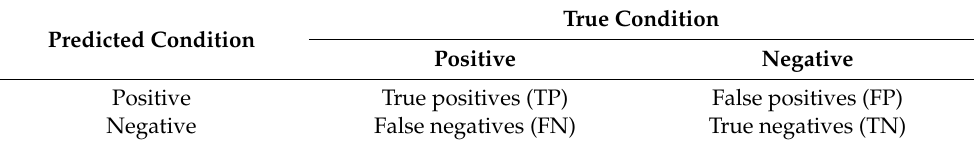
Table 2. Confusion matrix of a binary